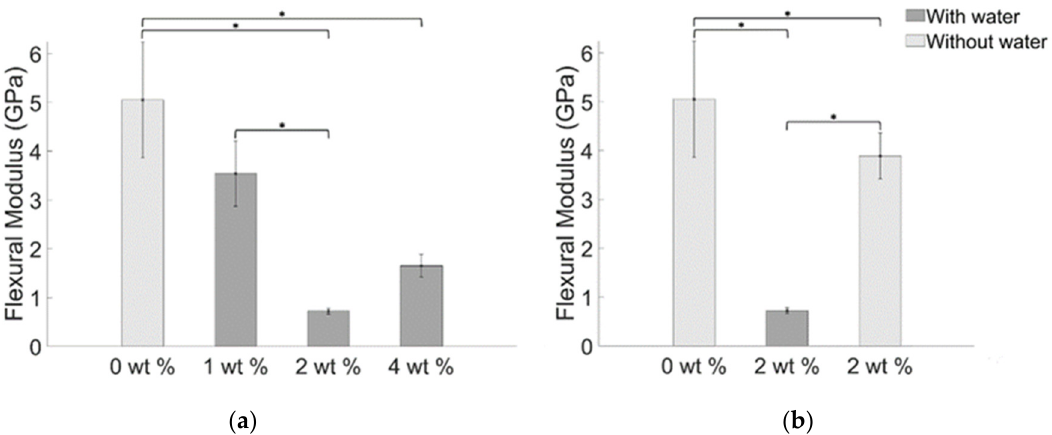
Figure 10. Mean values of flexural modulus for BiONPs—composite ( a ) with water and ( b ) without water. The bar with the asterisk indicates a statistical difference between the samples ( p < 0.05).